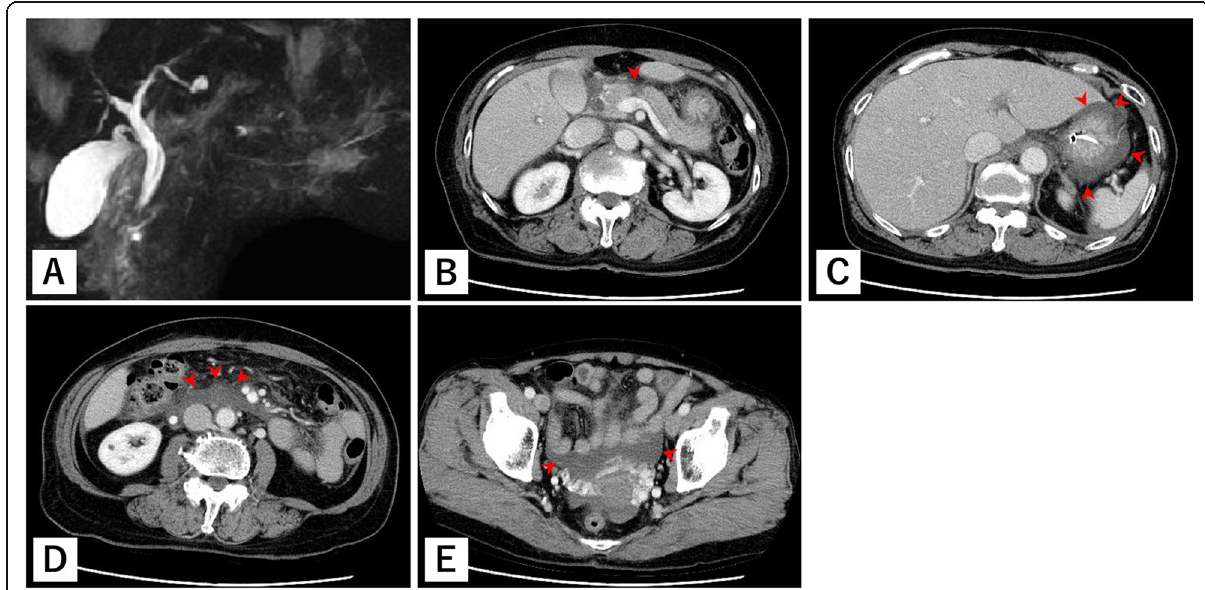
Fig. 1 Preoperative MRCP and CT findings. From MRCP, MPD disruption was unidentified ( a ). The CT scan revealed pancreatic injury ( b ) and increase in fluid collection around the stomach ( c ), the pancreatic injury site, retroperitoneum ( d ), and pelvic cavity ( e